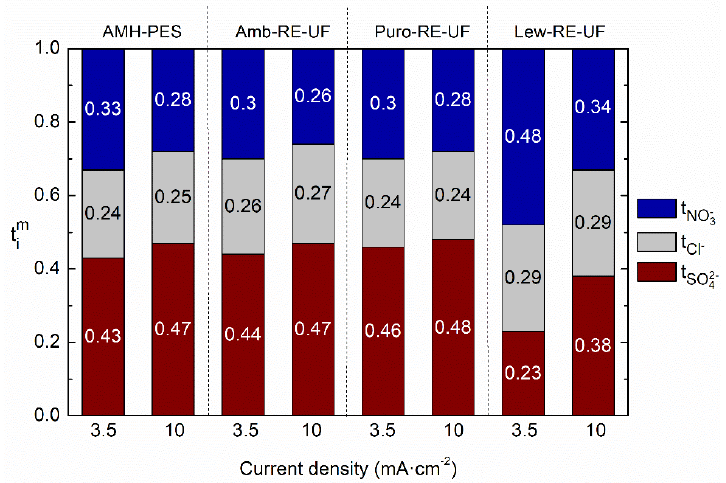
Figure 6. Ion transport numbers ( 𝑡 𝑖𝑚 ) of the counter-ions in the membrane in relation to the operating current ( j = 3.5 and 10 mA · cm − 2 ). Membranes: AMH-PES, Amb-RE-UF, Puro-RE-UF, Lew-RE-UF.